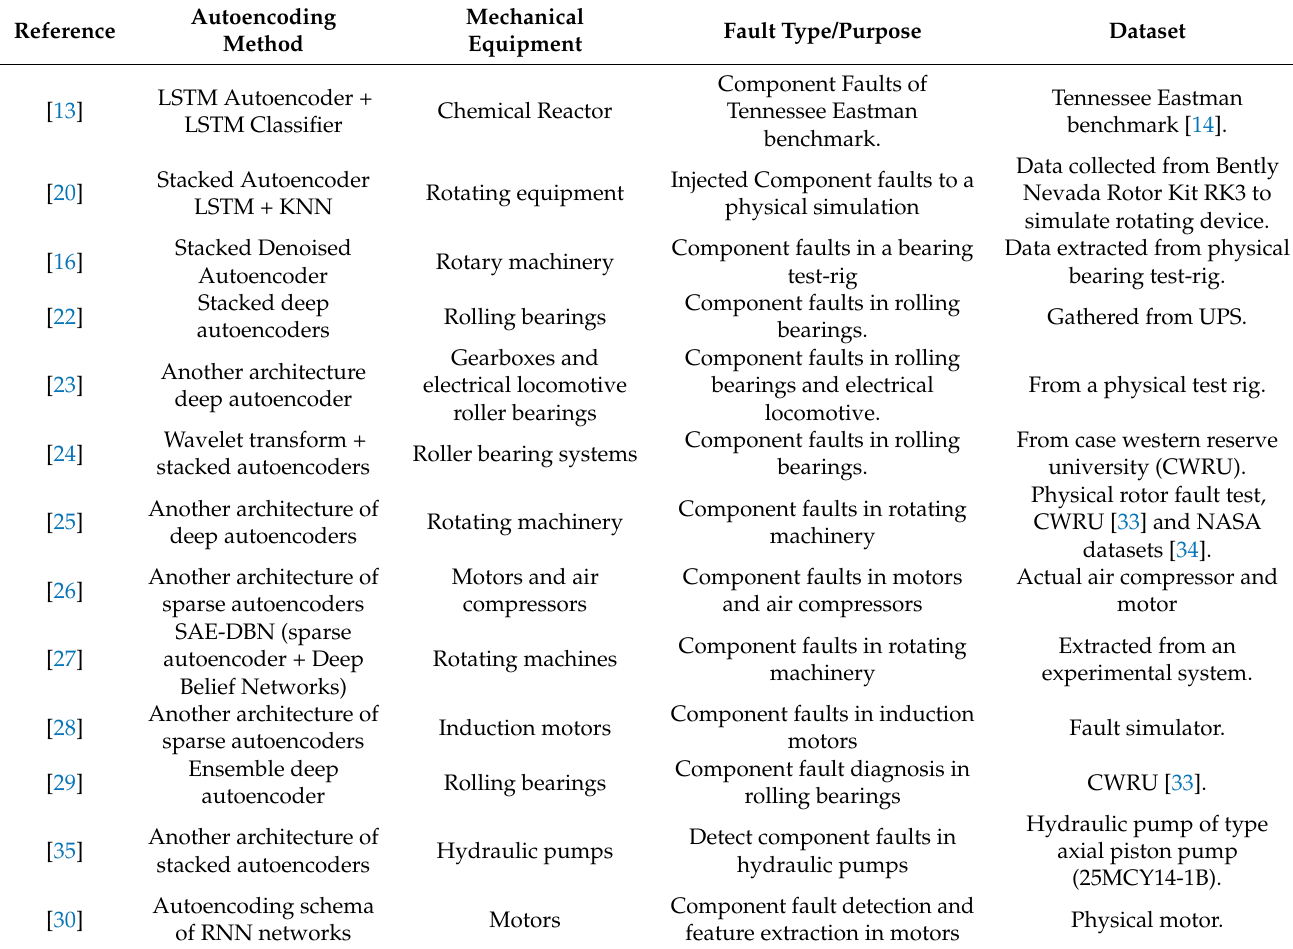
Table 1. Autoencoding-based Methods for FDD in Hydraulic